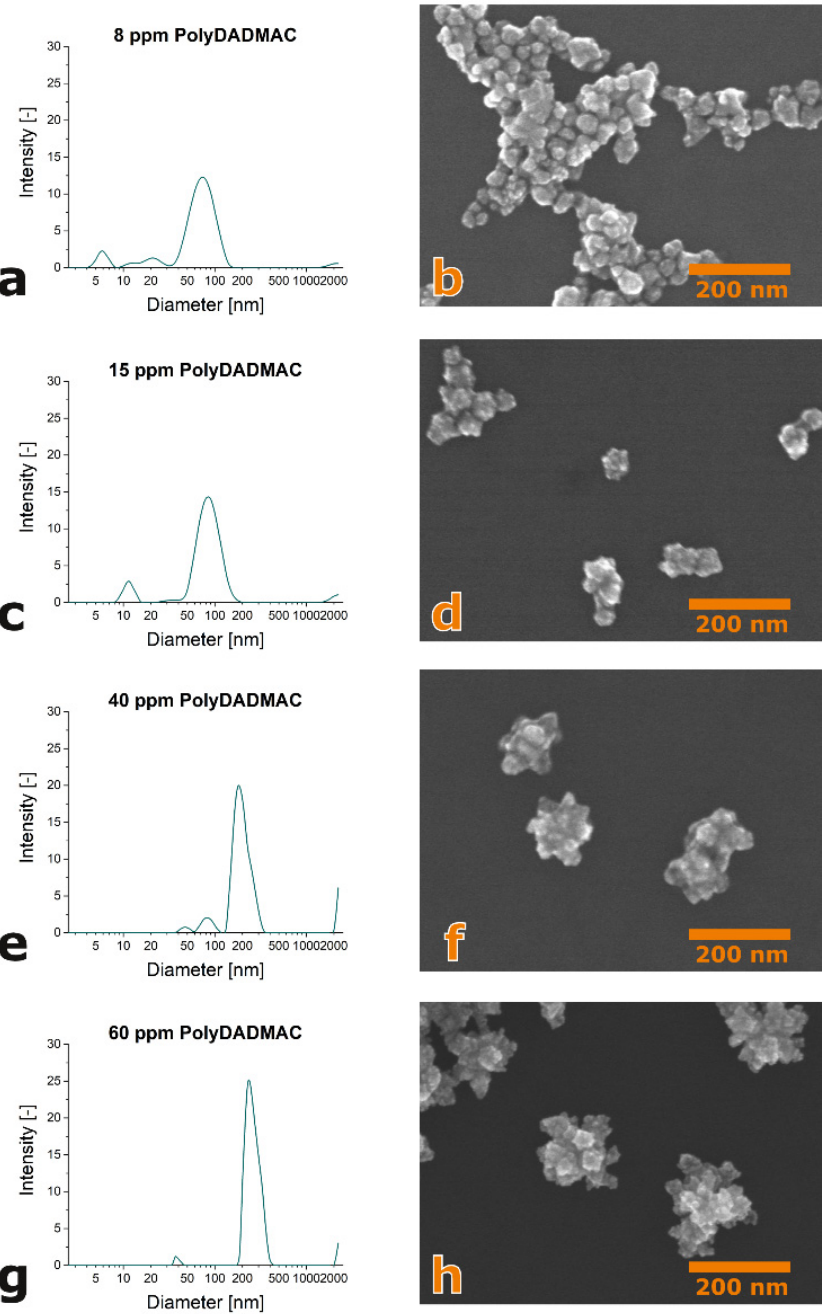
Figure 1. Dynamic Light Scattering (DLS) spectra and scanning electron microscope (SEM) images of gold nanoparticles formed in the presence of poly-DADMAC at 50 µM HAuCl 4 and 100 µM ascorbic acid in aqueous solution: ( a , b ) 8 ppm poly-DADMAC, ( c , d ) 15 ppm poly-DADMAC, ( e , f ) 30 ppm poly-DADMAC and ( g , h ) 60 ppm poly-DADMAC.